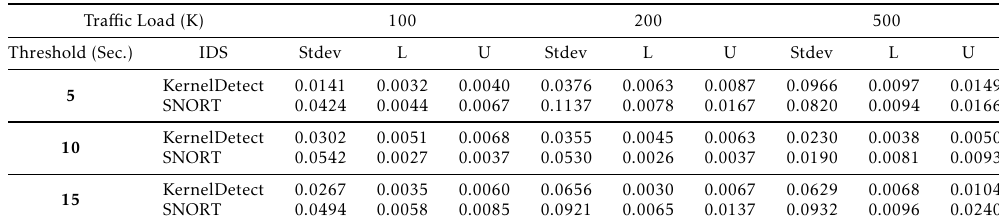
Table 4. 95% confidence interval measurements for mitigation time (seconds) between KernelDetect and SNORT where L and U represent their lower and upper bound,